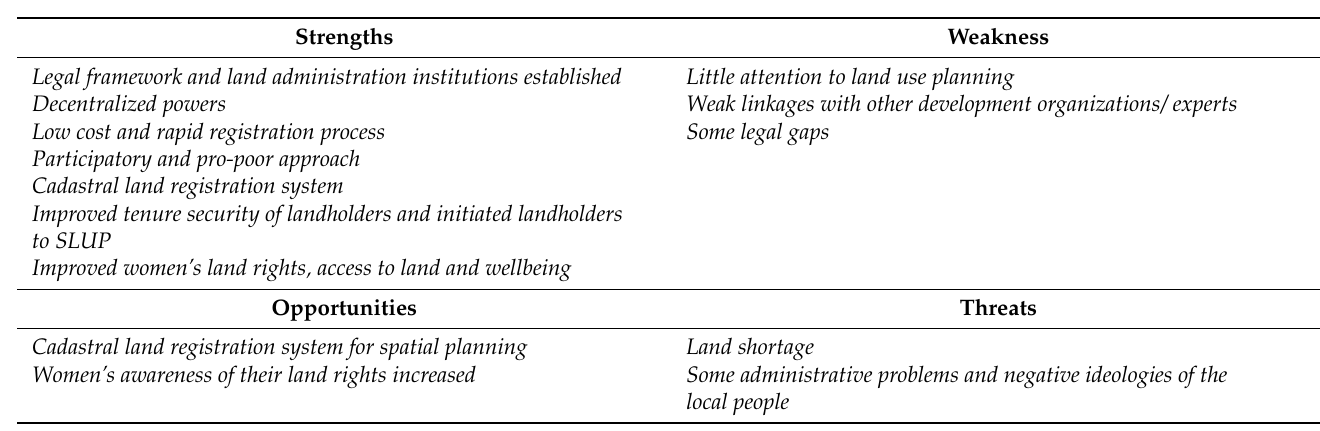
Table 1. SWOT of LRCP in the study